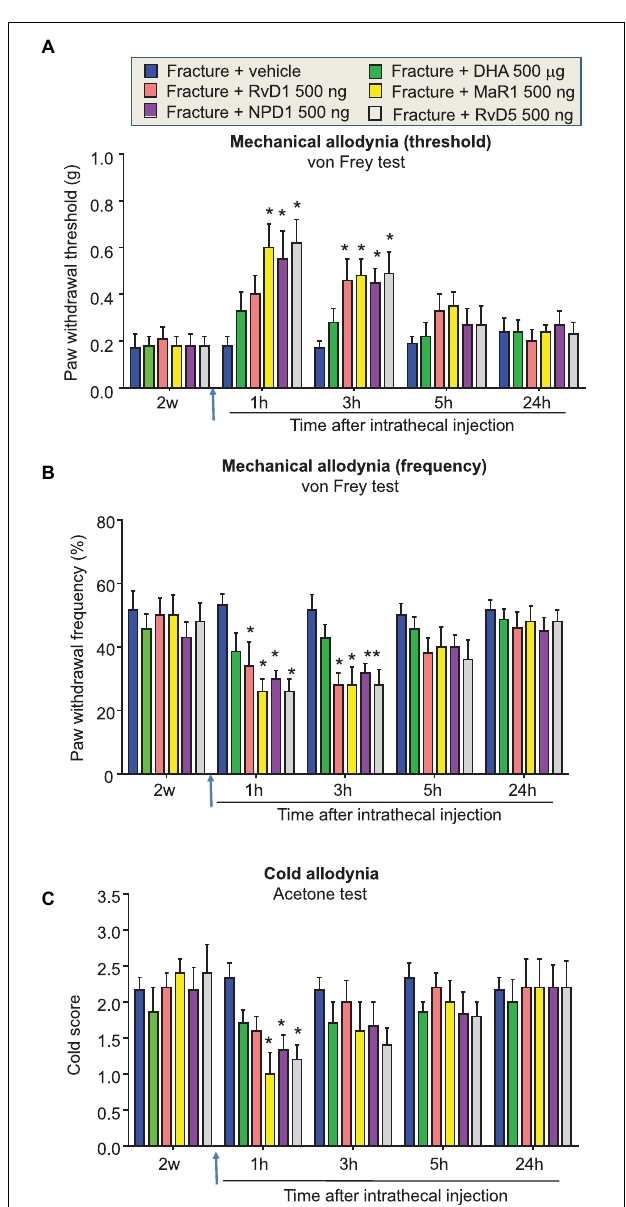
FIGURE 4 | Distinct actions of post-treatment of DHAand DHA-derived SPMs on fPOP. Impact of post-surgical treatment with DHA (500 µ g, i.t.) or DHA-derived SPMs RvD1, MaR1, NPD1, and RvD5 (500 ng, 10 µ l, i.t.), given 2 weeks after bone fracture surgery (indicated by blue arrows) on mechanical allodynia, assessed by measurements of paw withdrawal threshold (A) and paw withdrawal frequency (B) in the von Frey test, as well as of cold allodynia, assessed by cold response scoring in the acetone test (C) . Note that post-treatment of DHA has no effects on fPOP. ∗ P < 0.05 vs. vehicle (10% ethanol), two-way ANOVA followed by Bonferroni test, n = 5–7 mice/group. Data are presented as mean ±